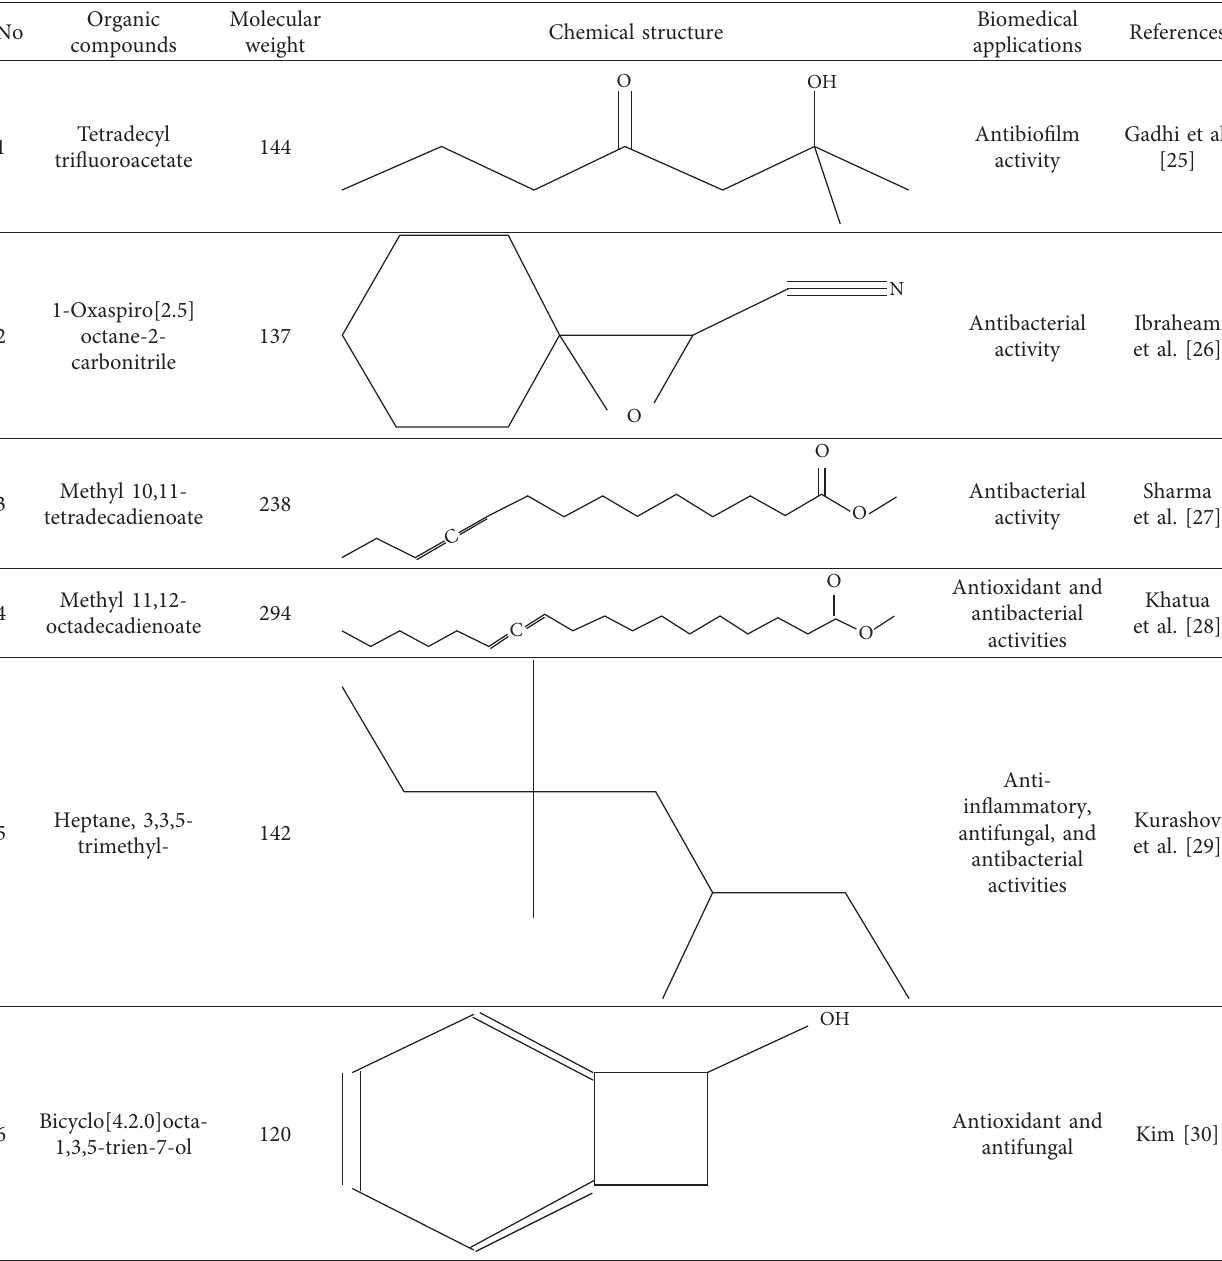
Table 3: Gas chromatographic analysis of Psammaplysilla sp. 1 ethyl acetate crude